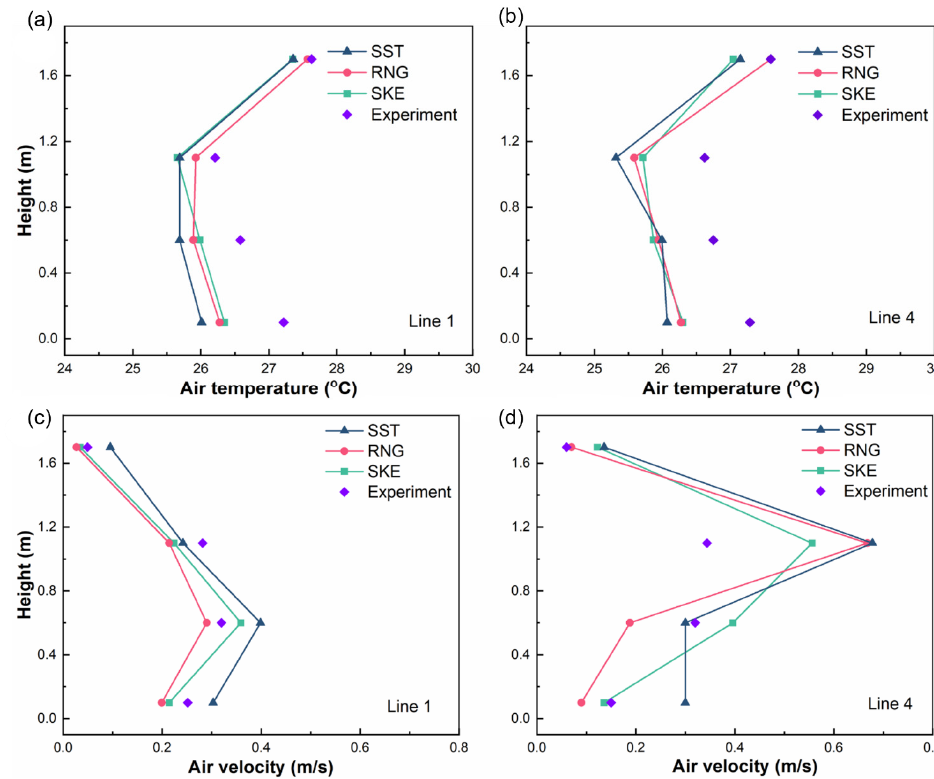
Figure 7. Comparison of different turbulence models and experiments: ( a ) air temperature of Line 1; ( b ) air temperature of Line 4; ( c ) air velocity of Line 1; ( d ) air velocity of Line 4.